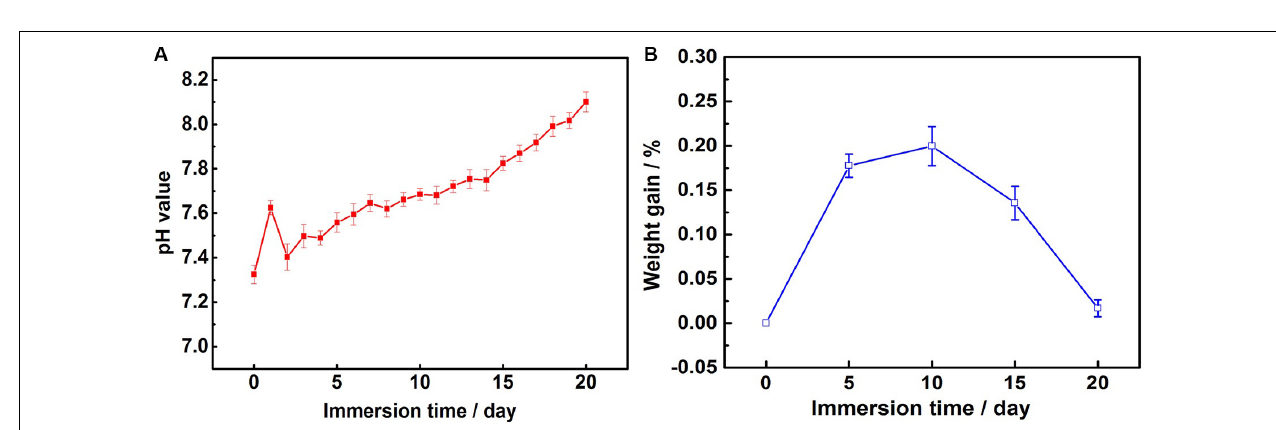
FIGURE 4 | Results of immersion tests: (A) variations in pH value of the SBF over time and (B) weight gain of MAO-ED samples after SBF immersions.